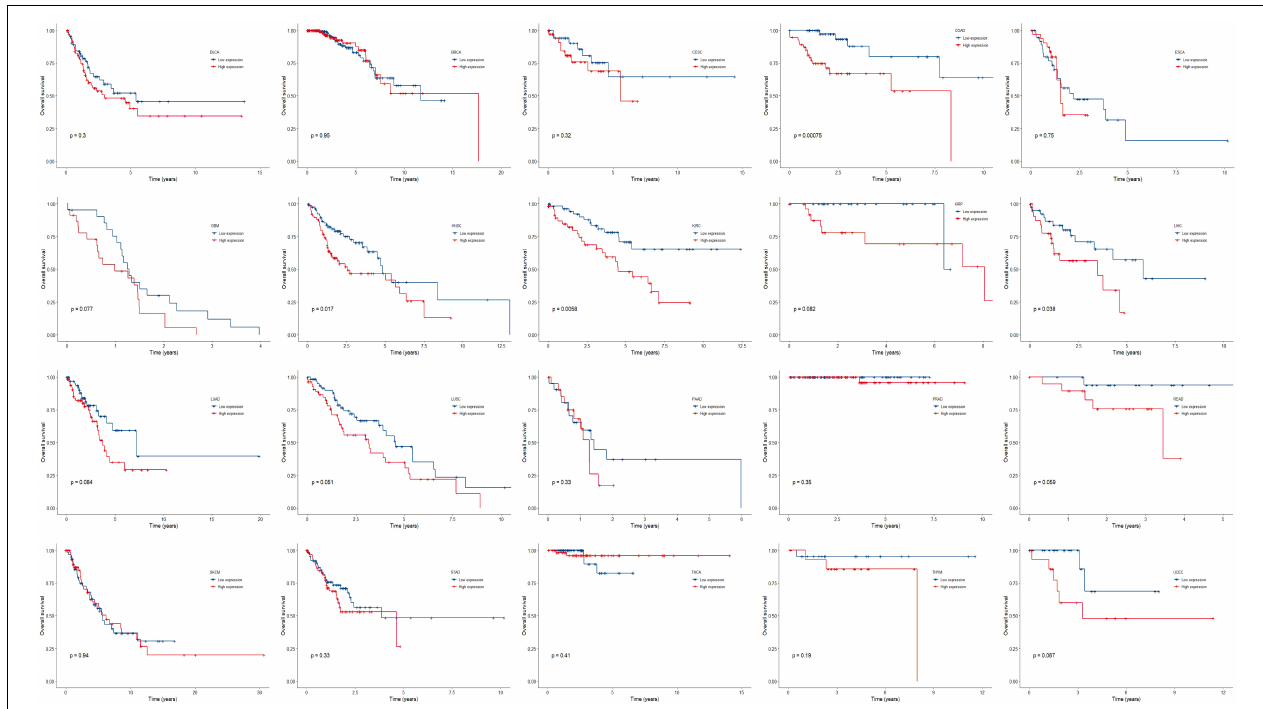
FIGURE 4 | Kaplan-Meier plots of overall survival in subgroups divided by all the three genes across 20 cancer types. p < 0.05 represents significant difference in survival